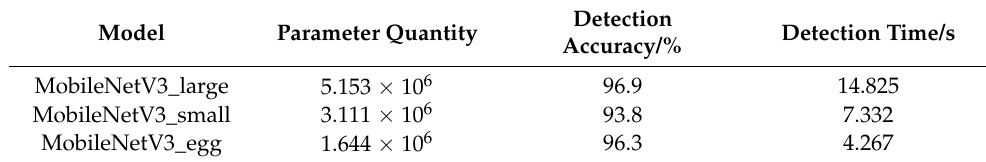
Figure 10. Changes in accuracy of MobileNetV3_egg network during training. Table 5. Comparison of the improved MobileNetv3_egg model to MobileNetv3_large and Mo-